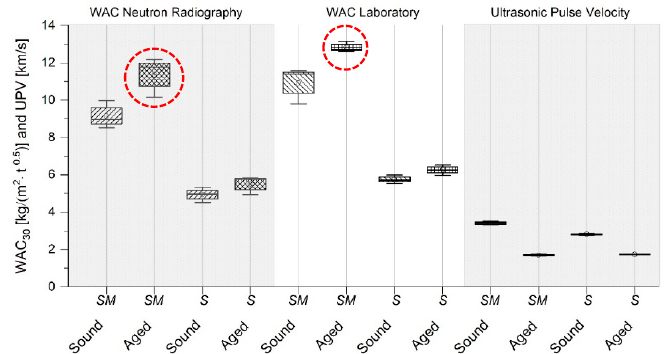
Figure 3. The effect of thermal ageing on St. Margarethen Limestone ( SM ) and Schlaitdorf Sandstone ( S ) determined by the water absorption coefficient after 30 min, as well as the ultrasonic pulse velocity before ( sound ) and after artificial ageing ( aged ). WAC was calculated from image analysis obtained from neutron radiographs and gravimetrical laboratory analysis. The corresponding values can be extracted from Supplementary Materials, Table S1.